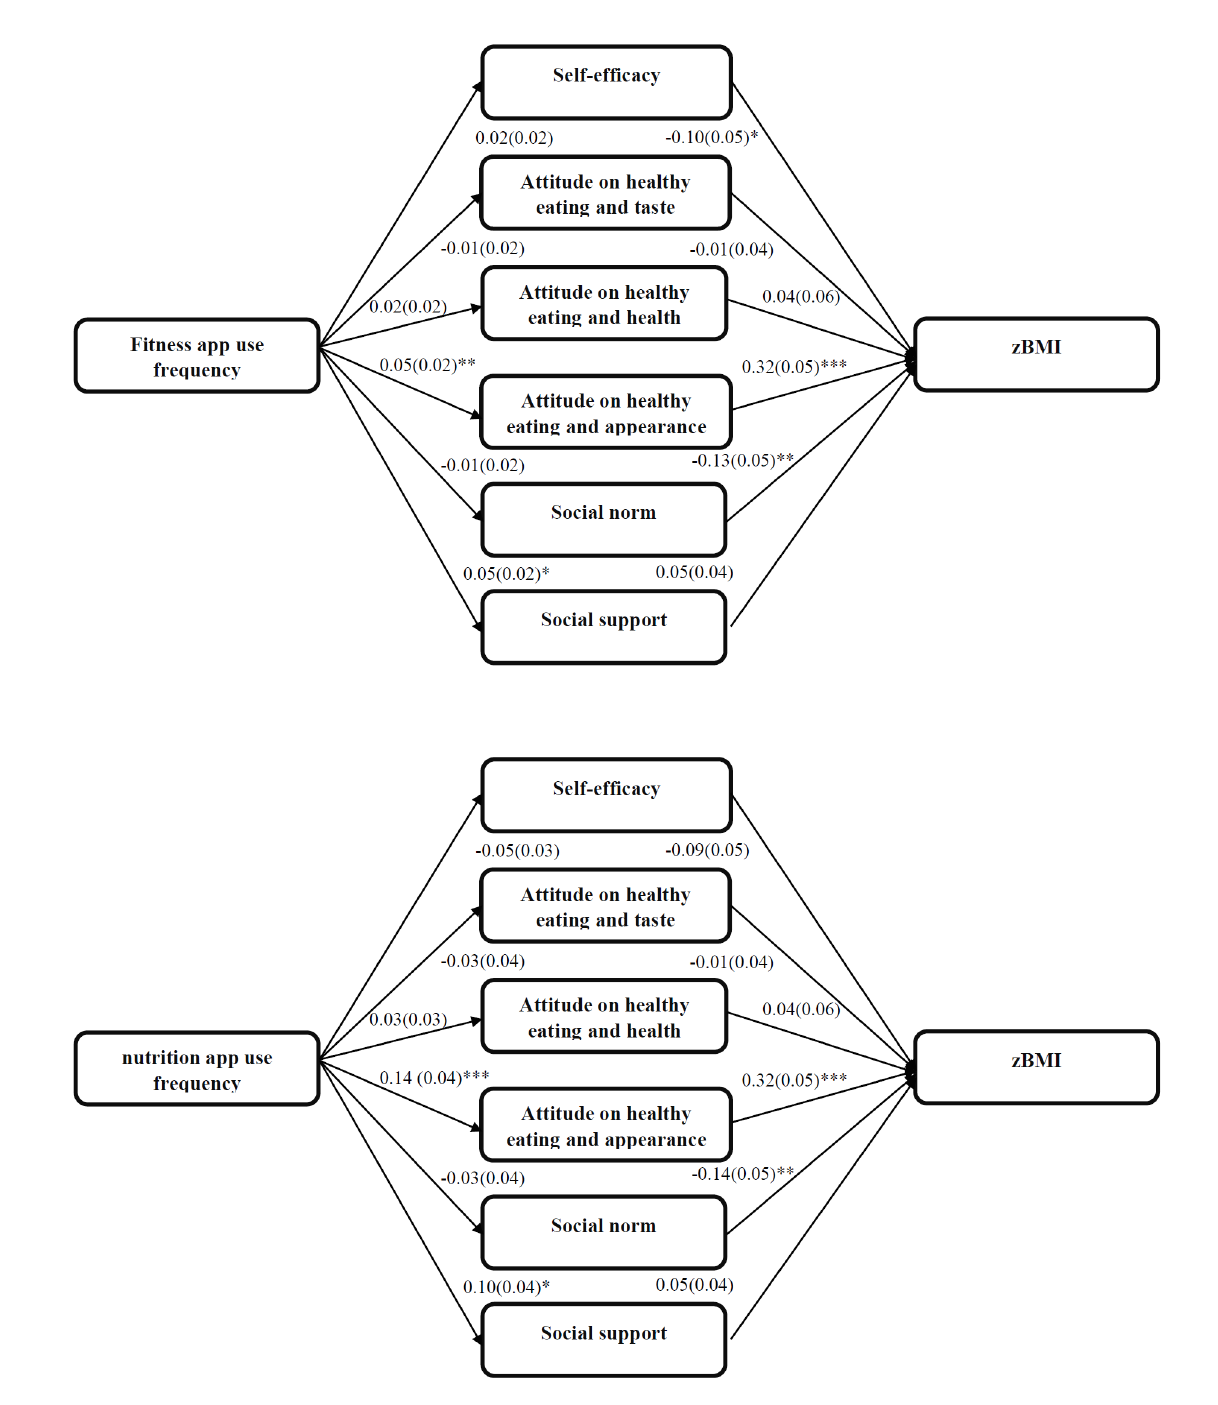
Figure 2. Multiple mediation zBMI. Analyses controlled for sex and education type; * P<.05, ** P <.01, *** P